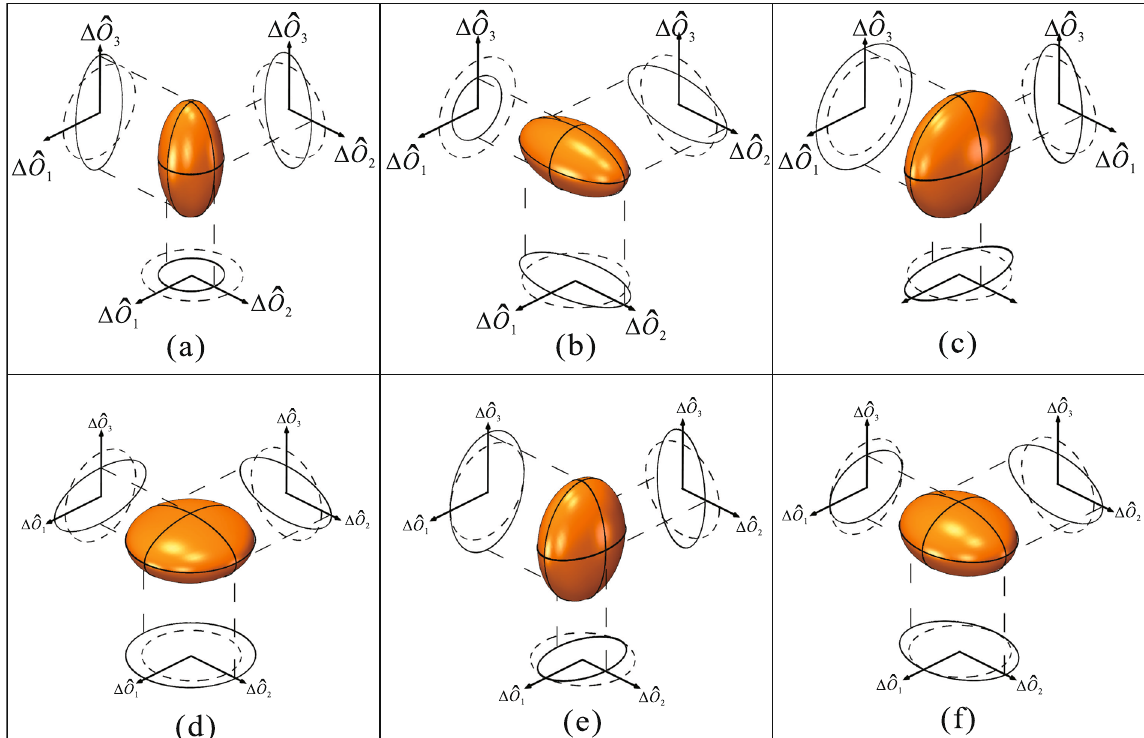
Figure 2. Orbital Poincaré spheres for the different types of OAM squeezed